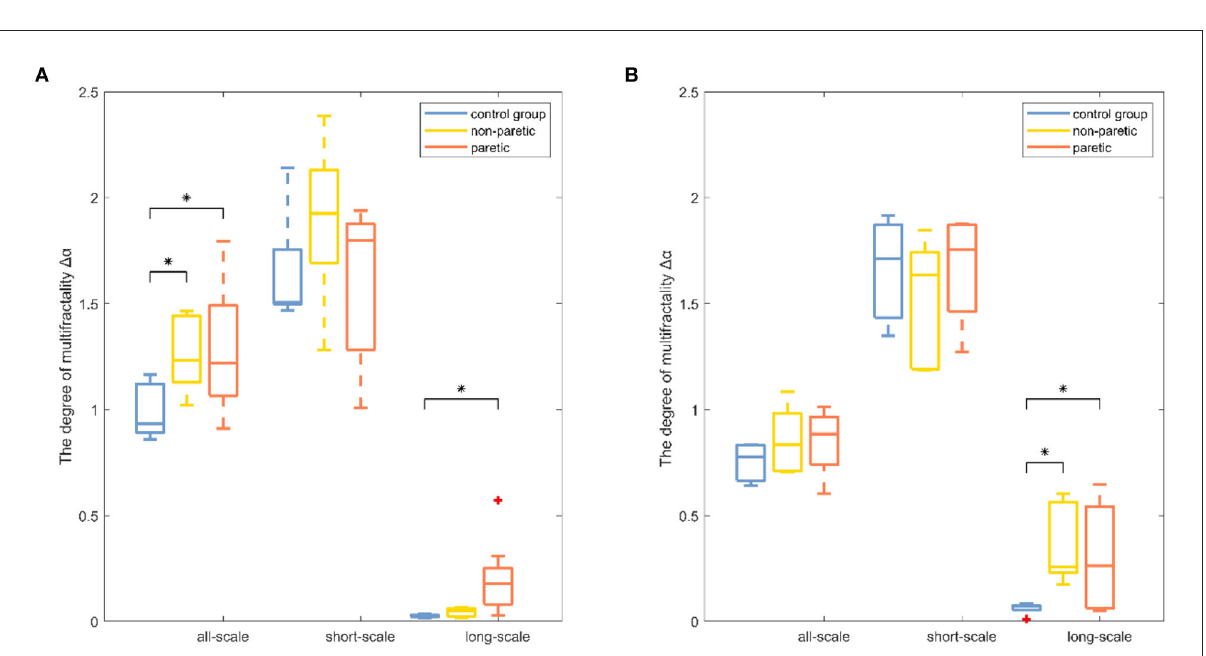
As is evident in Tables 1, 2, the statistical differences of 1 α and h (2) of each group of shuffled series were significantly smaller. The results showed that the shuffled